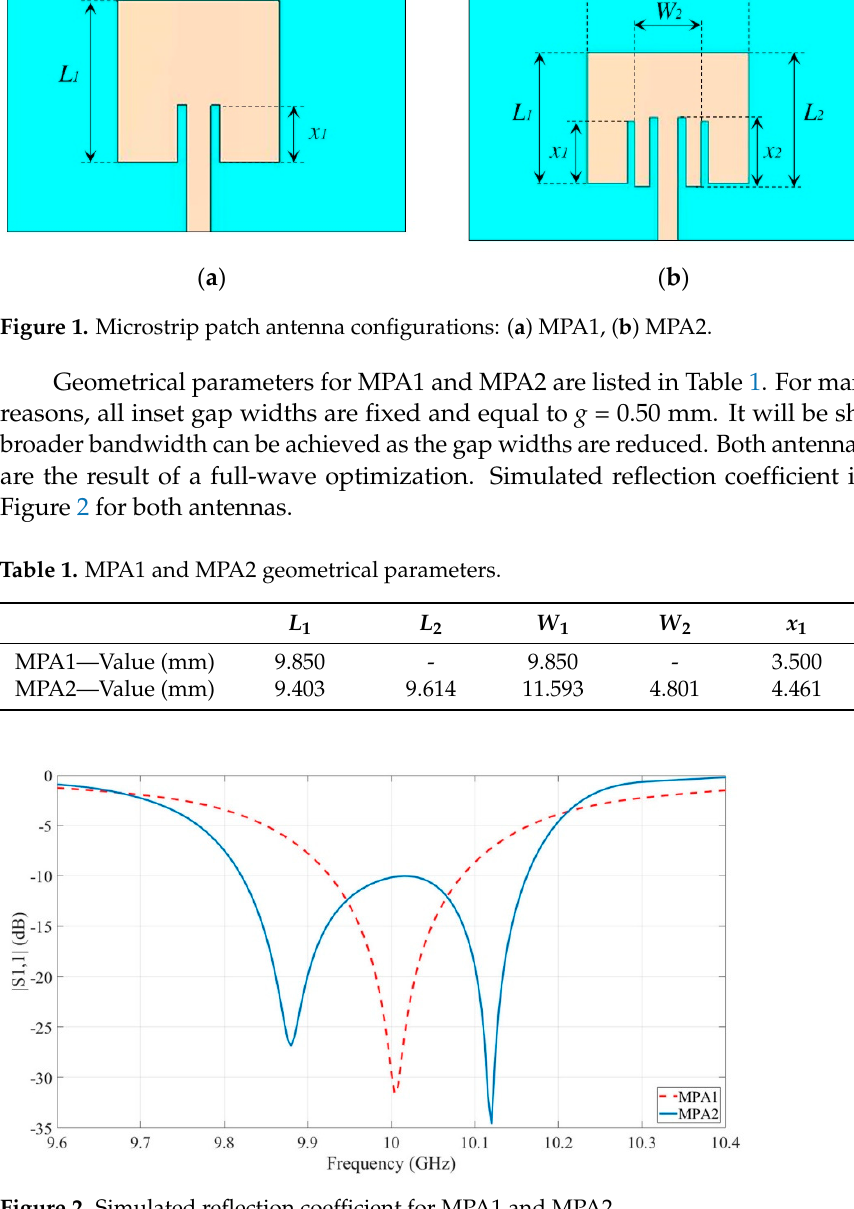
Table 1. MPA1 and MPA2 geometrical parameters.